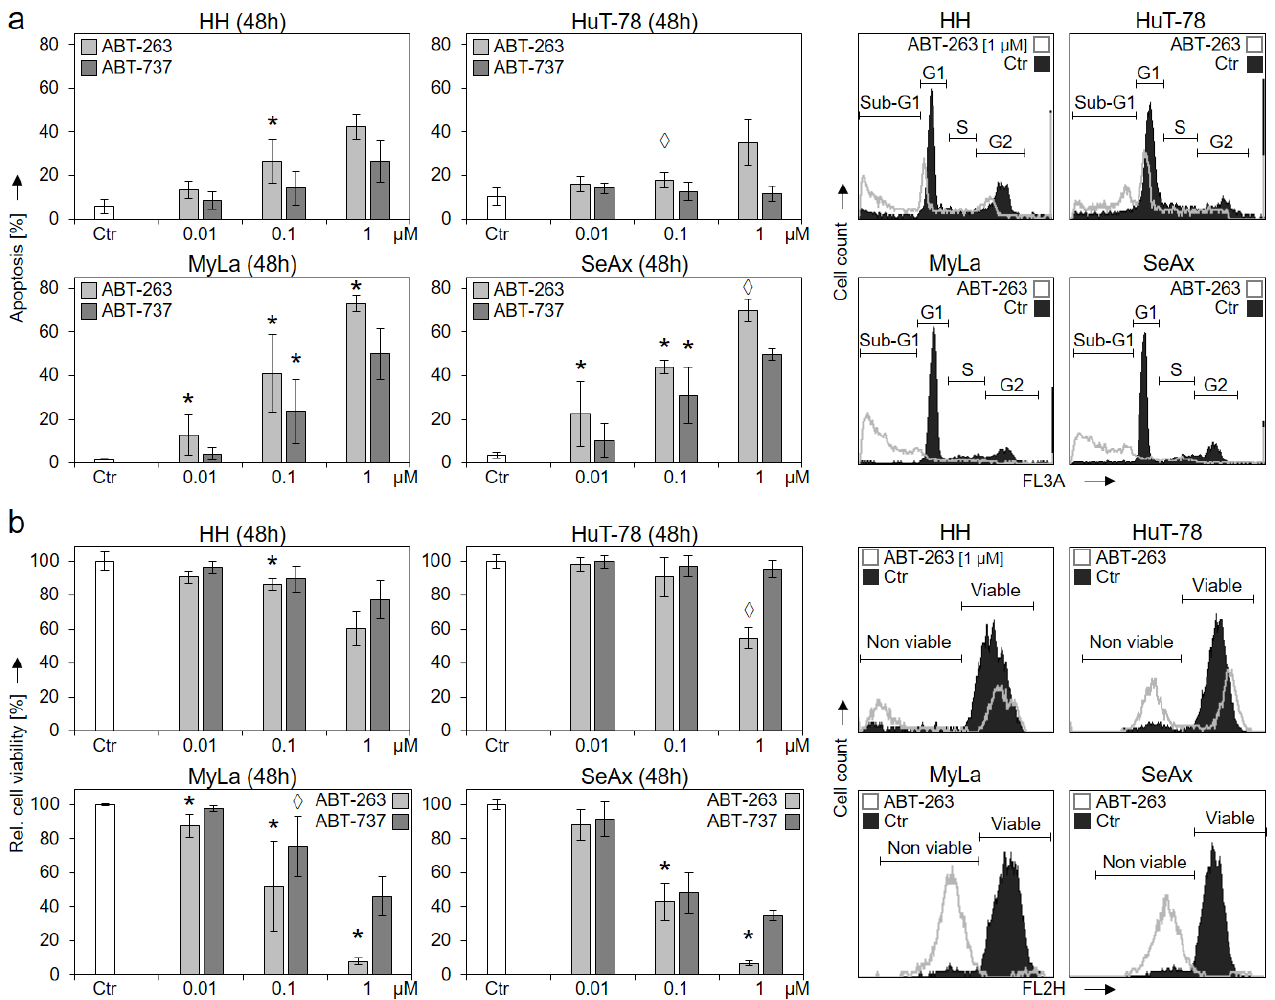
Figure 4. Strong response of S63845-resistant cells to ABT-263 and ABT-737. CTCL cell lines were treated with increasing concentrations (0.01, 0.1, 1 µ M) of ABT-263 (light grey) and ABT-737 (dark grey). Apoptotic rates ( a ) were determined by sub-G1 assay, and cell viability rates ( b ) were deter- mined by calcein staining at 48 h. Apoptotic rates correspond to percentages of sub-G1 cells (cells with fragmented DNA). Cell viability values were calculated in relation to non-treated controls (Ctr), which were set to 100%. Example histograms of controls and of cells treated with 1 µ M ABT-263 are shown on the right side in overlays. Cell populations in cell cycle phases G1, S, G2 and sub-G1 ( a ) as well as non-viable and viable cells ( b ) are indicated. Mean values of triplicates ± SD of representative experiments are shown. At least three independent experiments (each one with triplicates) were performed for ABT-263 (0.01, 0.1 and 1 µ M) as well as for ABT-737 (0.1 µ M), which showed highly comparable results. Statistical significance was calculated from the mean values of independent experiments, and is shown for treated cells vs. controls (*, p < 0.05). For some values, a statistical trend was also indicated ( ♦ , p < 0.1). For ABT-737 (0.01 and 1 µ M) only two independent experiments (each one with triplicates) were performed. Thus, here, median values are given, and no statistical significance is